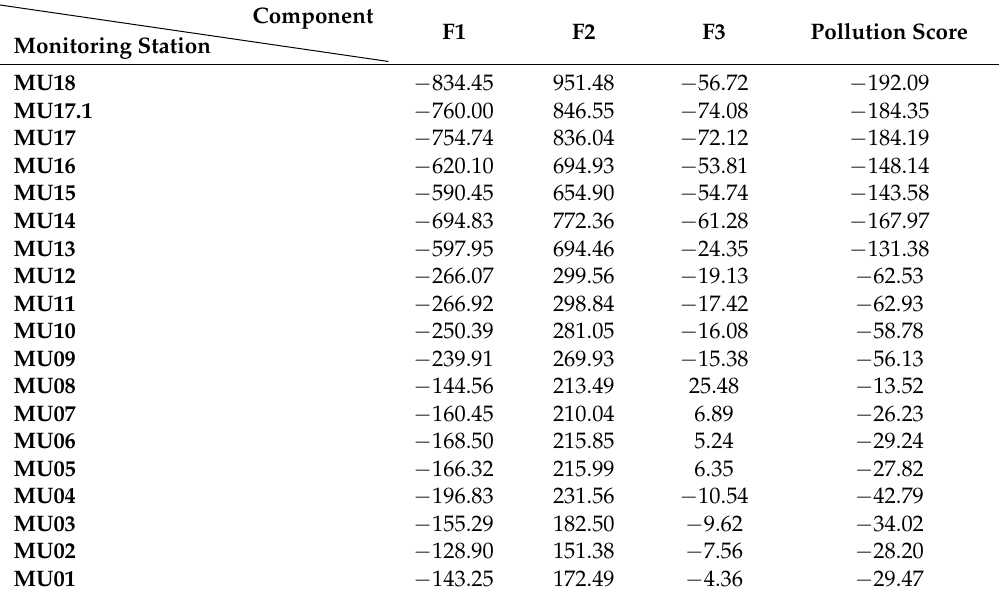
Table 4. Main component score and comprehensive pollution score.